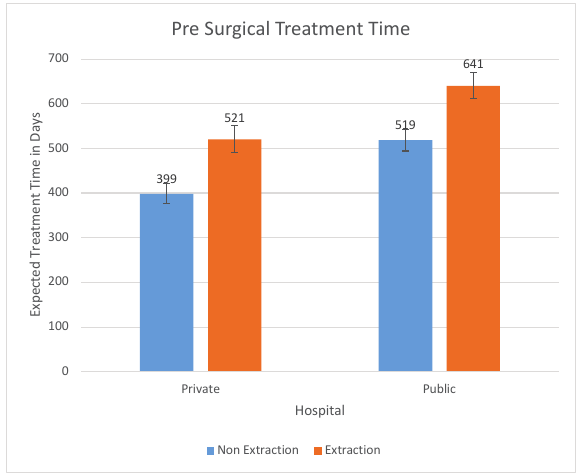
Figure 6. Pre-surgical treatment time in private compared to public environment dependent on extraction or non-extraction